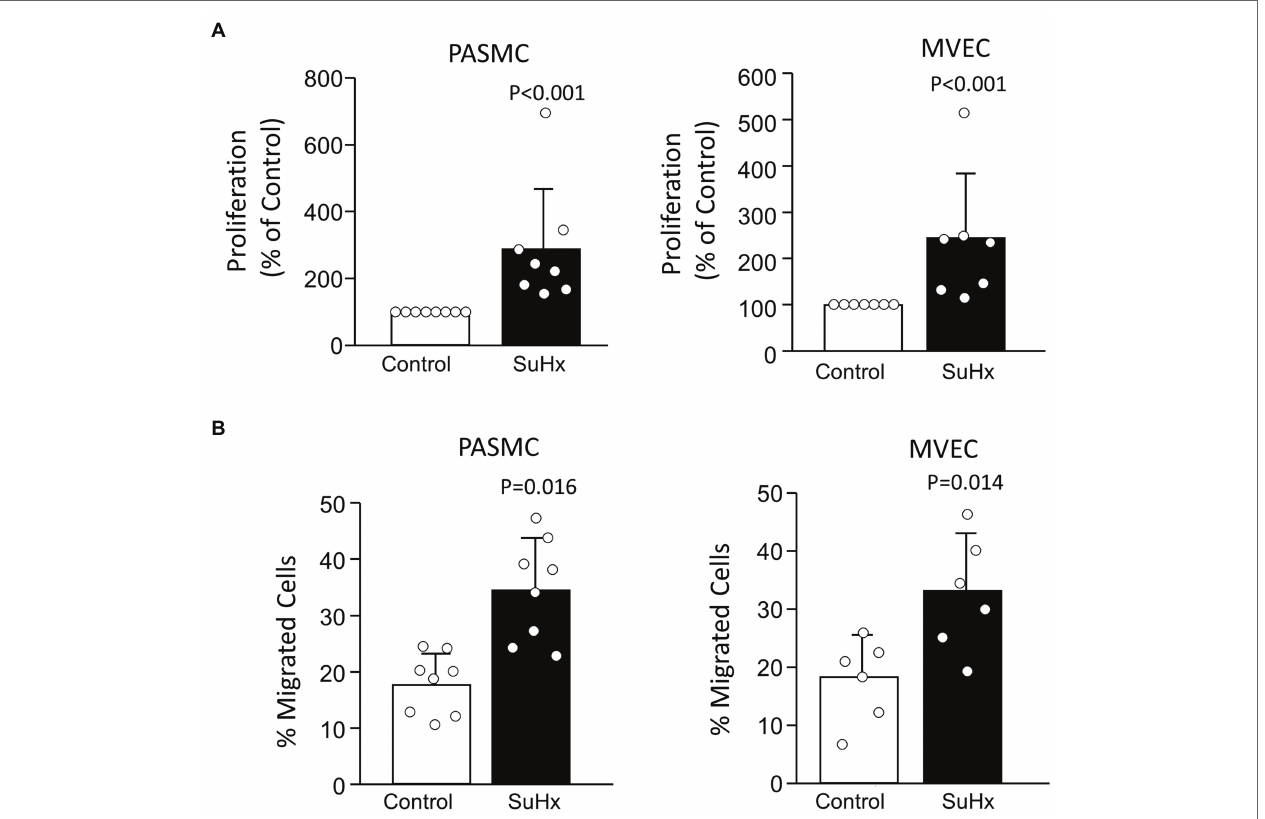
FIGURE 4 | Proliferation and migration in cells from Control and SuHx rats. (A) Bar graphs (mean ± SD values) for proliferation, measured by BrdU incorporation normalized to Control value, in PASMC and MVEC isolated from control and SuHx rats. Values of p were determined from Mann-Whitney Rank Sum test. (B) Bar graphs (mean ± SD values) for migrated cells (% of total) were assessed by transwell assay using PASMCs and MVECs from control and SuHx rats. Values of p determined by t -test. For all graphs, each dot represents samples from different